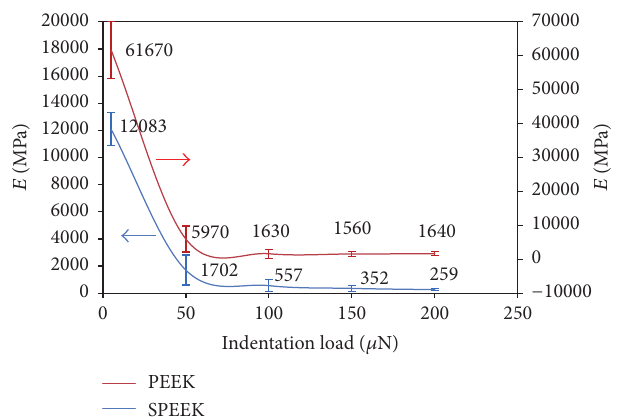
Figure 7: Calculated Young’s modulus versus piezo displacement of (a) SPEEK and (b) PEEK using the Hertz model via the NTS.